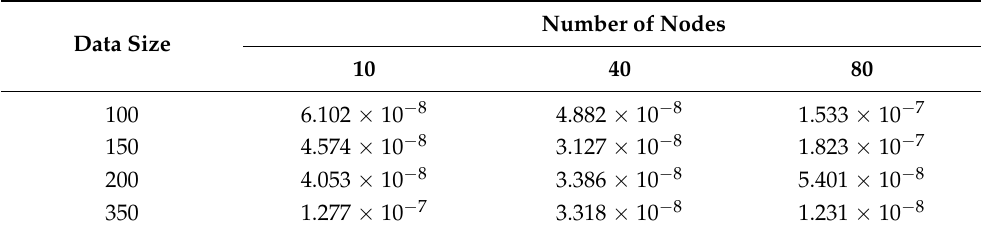
Table 6. Results of the mean square error analyzing of varying sizes of data points iterations and number of nodes in layers in the